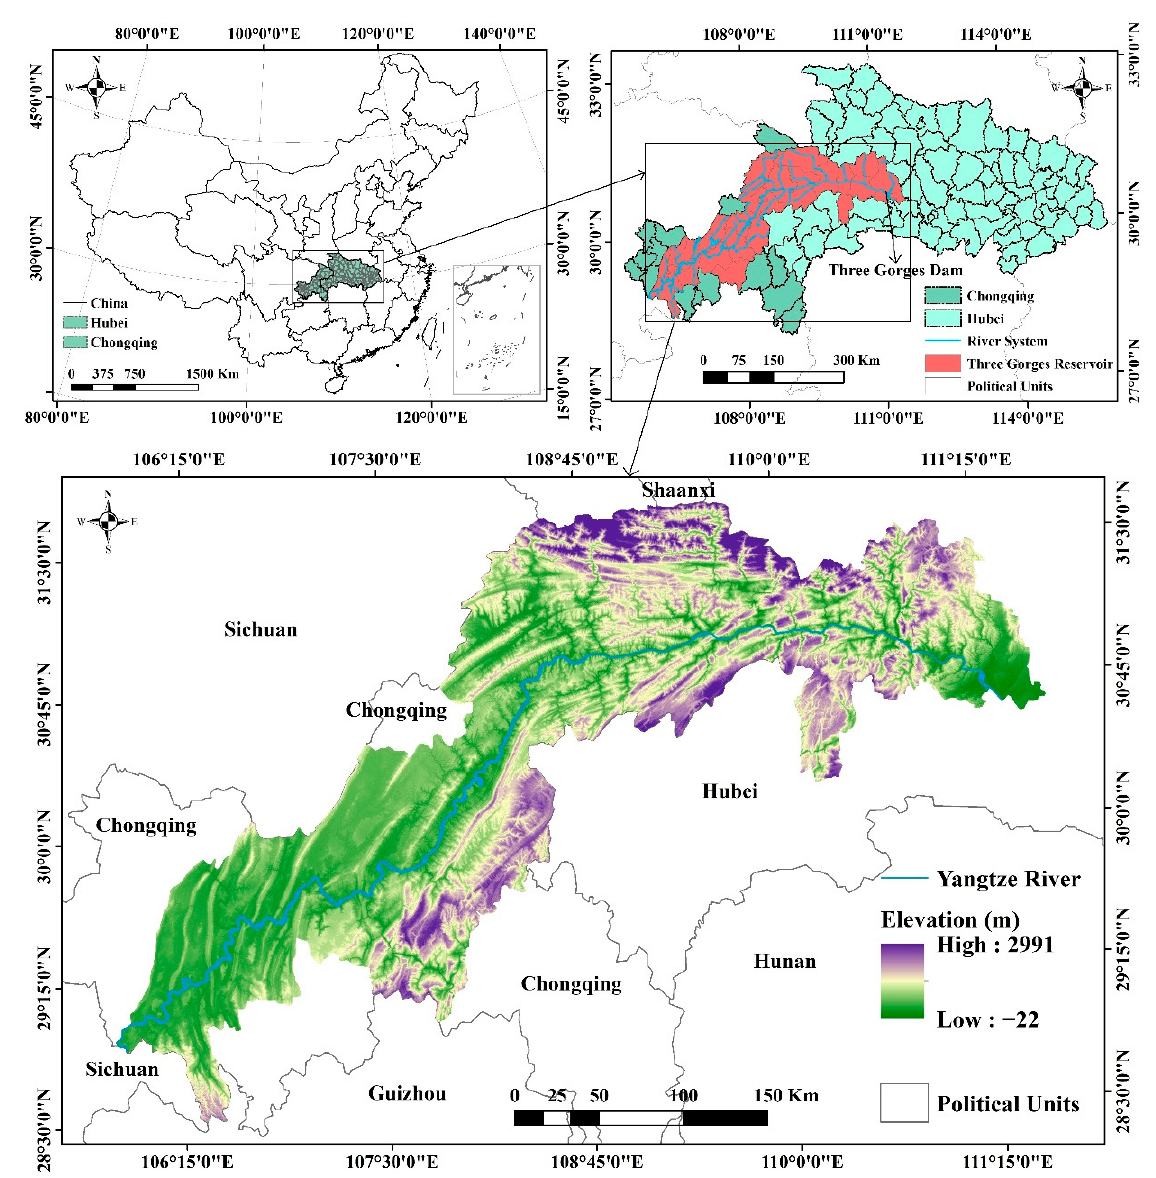
Figure 2. Geographical location of the Three Gorges Reservoir Area.